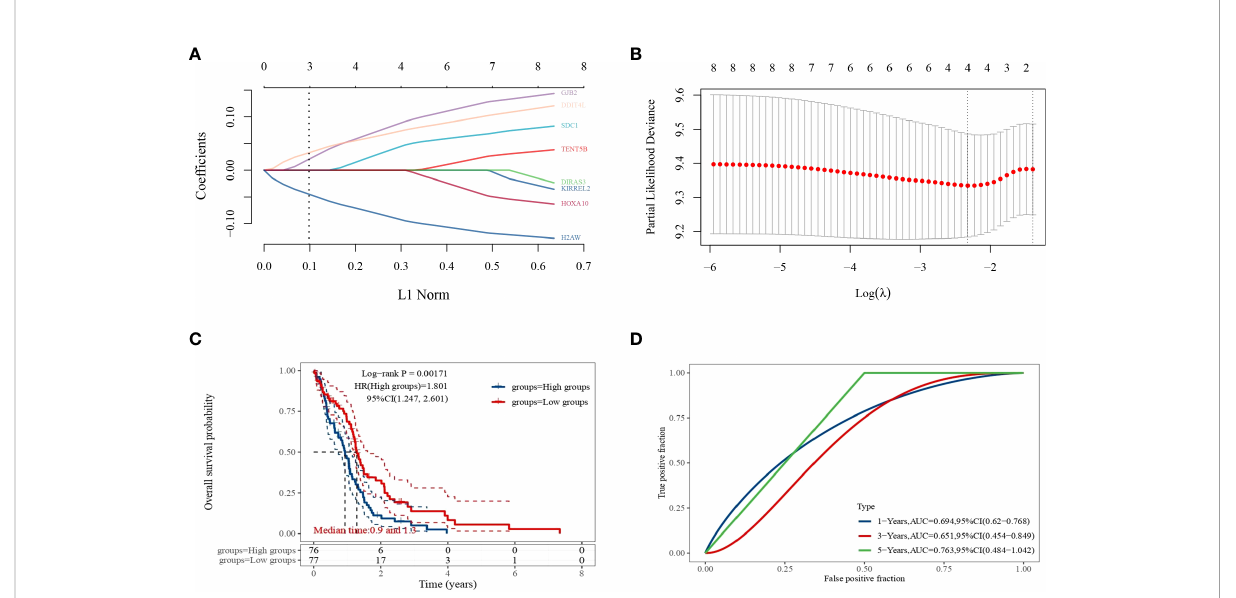
FIGURE 5 LASSO regression analysis. (A) Coef fi cients of selected features expressed as l parameters; (B) partial likelihood deviation plotted with log(l) using LASSO regression analysis model; (C) Kaplan – Meier survival curves for patients in the high and low expression level groups; (D) time- dependent ROC curve